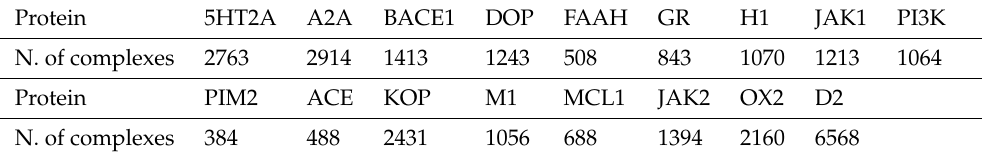
Table 2. Breakdown of the protein–ligand complexes included in the computer-generated database. The following legend defines the protein acronyms: 5HT2A: human 5-HT 2A receptor (pdbcode: